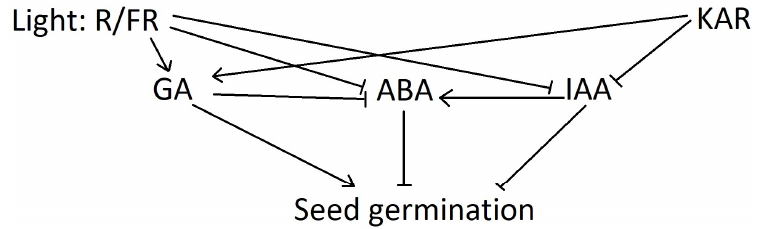
Figure 2. The impact on KAR on phytohormonal balance determining seed dormancy and